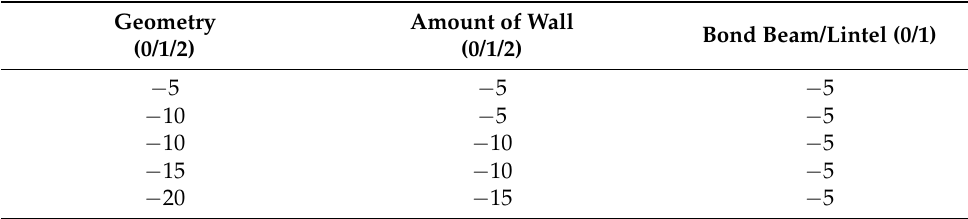
Table 10. Negative scores in the plan